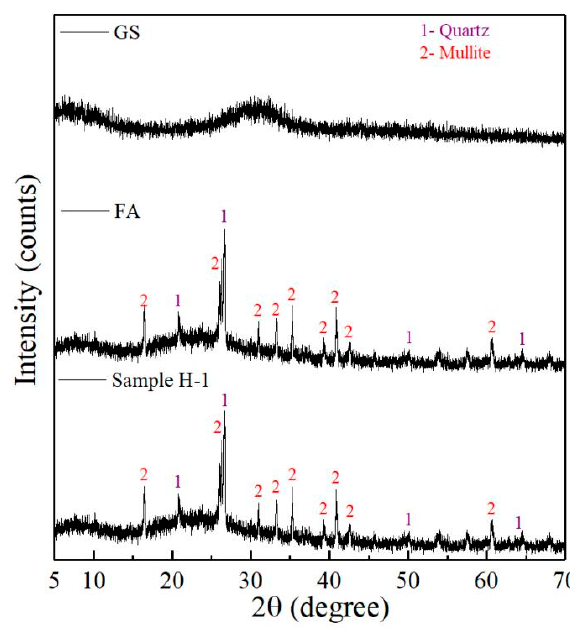
Figure 2. XRD patterns of the raw materials.